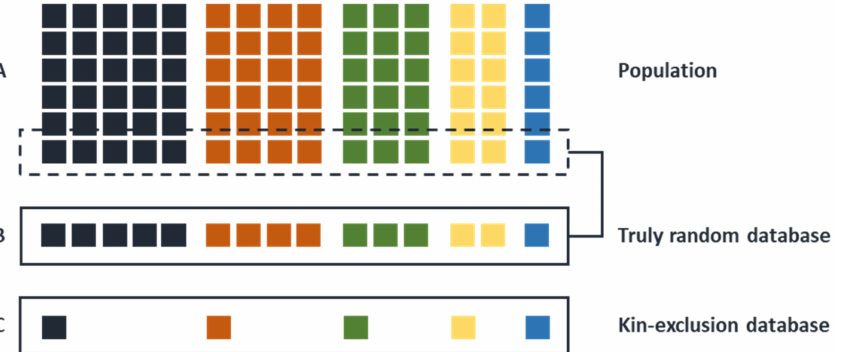
Figure 3. The difference between a random DNA database and a kin-selected DNA database. If we want to create a reference database of allele frequencies for autosomal STR loci in a human population ( A ), it was common practice to avoid the inclusion of biological relatives in such a population sample, i.e., an unknown number of reference databases are based on kin-exclusion ( C ). If the same DNA samples are subsequently used for the creation of a Y-STR reference database, such a kin-exclusion must, per definition, lead to the under sampling of large Y-kin groups. In the ideal